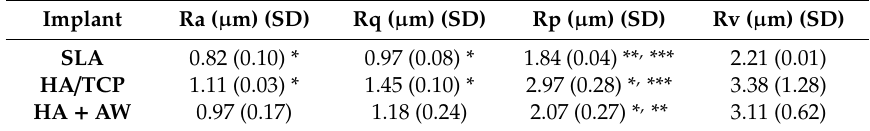
Table 3. Profile roughness parameters.